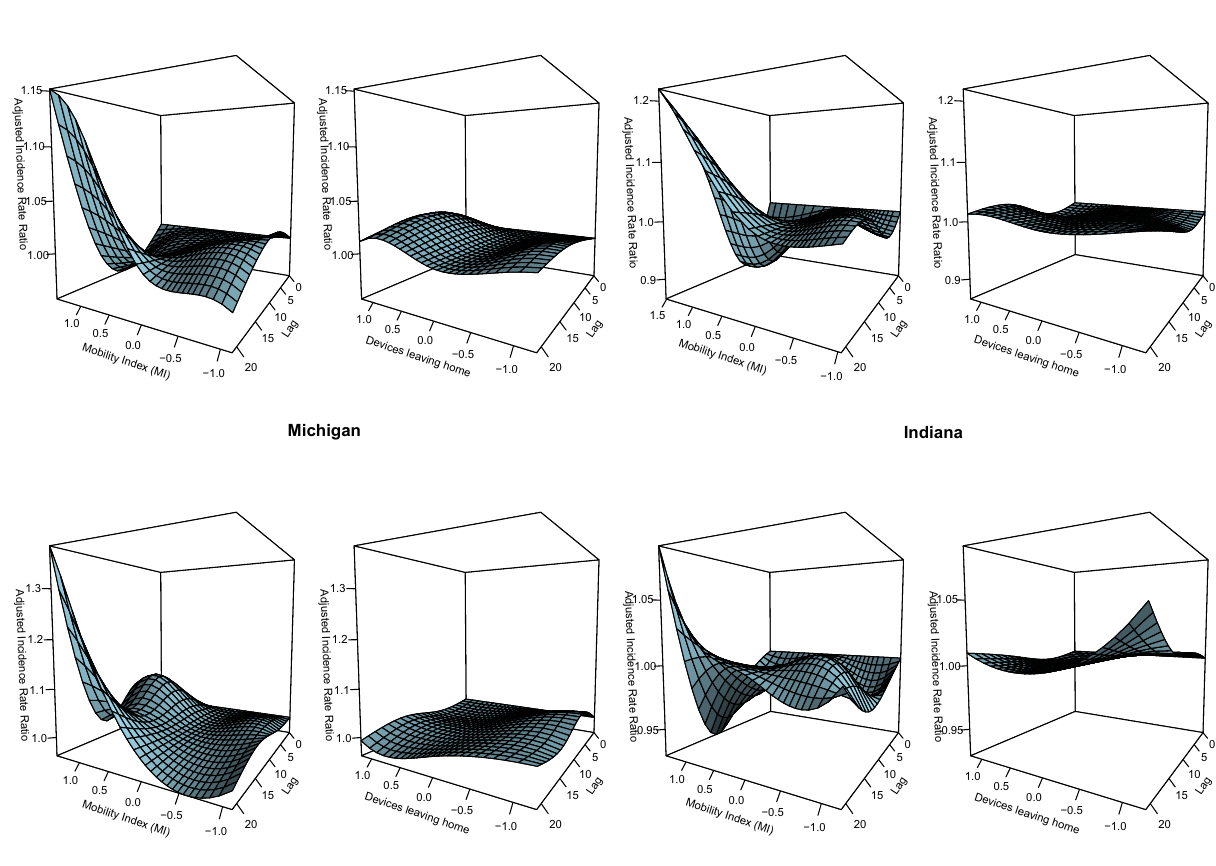
Figure 3. Model results comparing the MI and its association with COVID-19 cases and a commonly used single metric of mobility (fraction of devices leaving home). For each state, the left panel summarizes the multidimensional MI; the right panel represents the percentage of devices leaving their home (x-axis); y-axis is the adjusted incidence rate ratio of COVID-19, at varying lagged response (0–21 days) (z-axis). State Residual deviance Degrees of freedom Reduction in deviance for the MI model